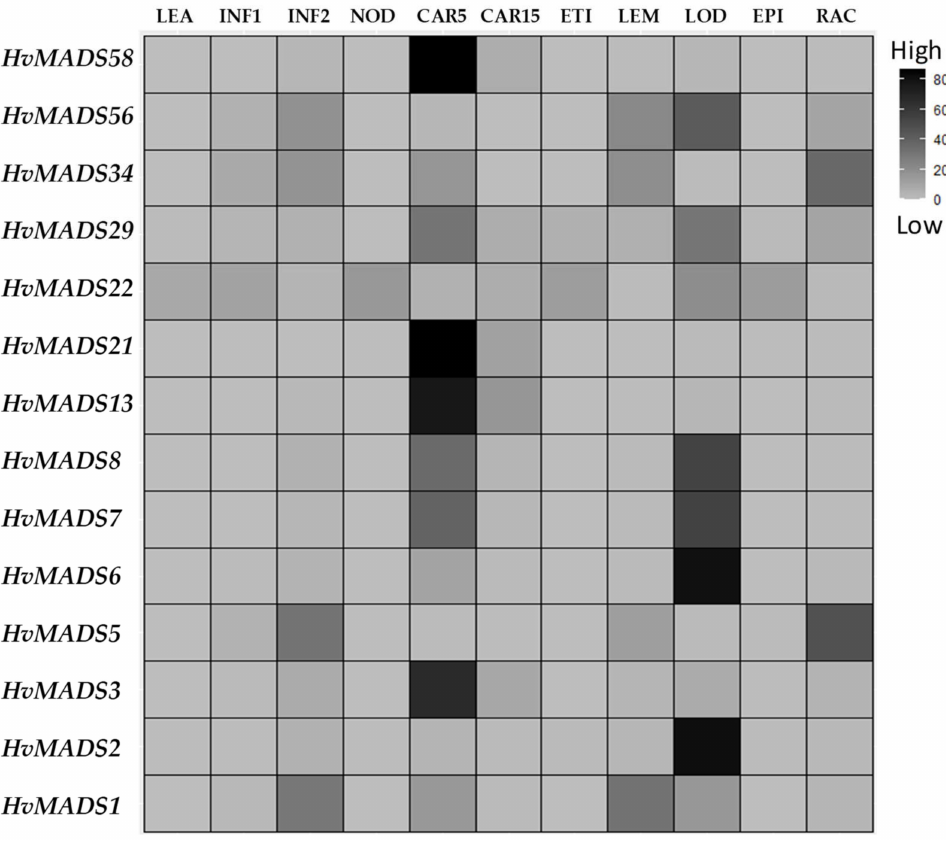
Figure 4. Clustering analysis of 14 HvMADS-box transcription factor gene transcripts in different barley tissues. LEA, leaves 17 days after planting (DAP); developing inflorescence 5mm (INF1, about 30 DAP); developing inflorescence 10–15mm (INF2, about 50 DAP); developing tillers (NOD), developing grain 5 days after anthesis (CAR5), developing grain 15 days after anthesis (CAR15), etiolated seedling (ETI), inflorescence lemma (LEM), inflorescence lodicule (LOD), epidermal strips (EPI), inflorescences rachis (RAC). Raw data from the https://apex.ipk-gatersleben.de/apex/f?p=284:10 website (accessed on 9 November